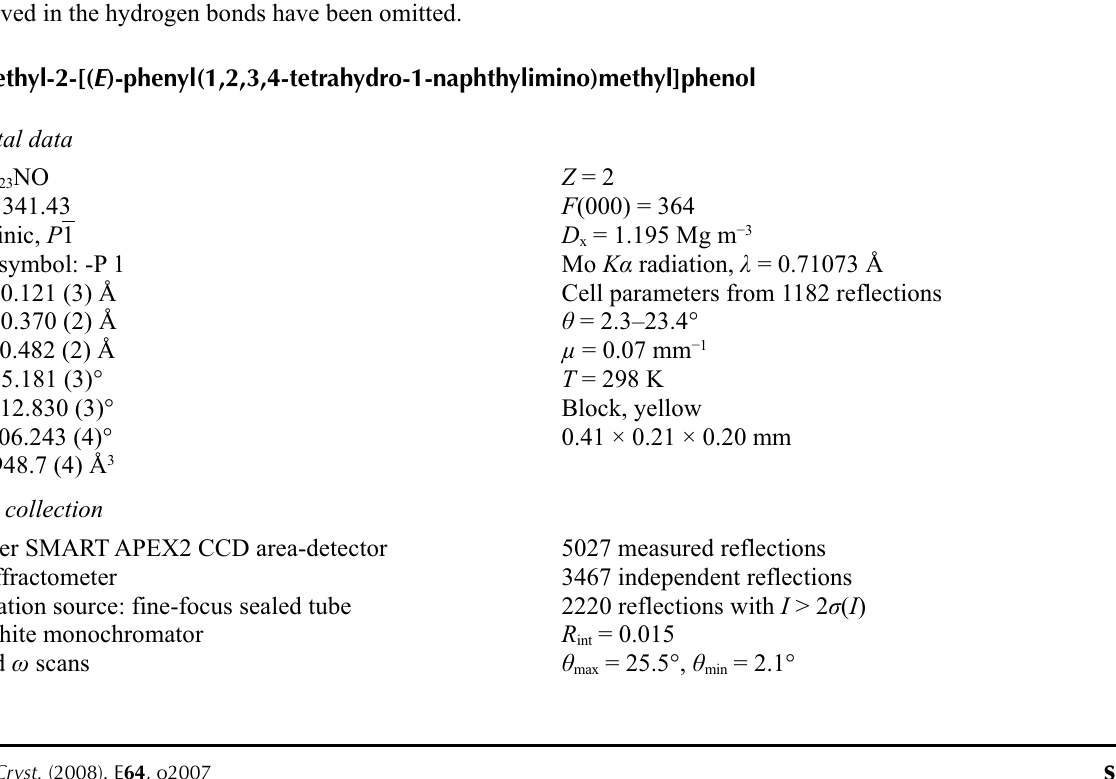
A packing diagram of (I), view down the b axis, showing the O1—H1···N1 hydrogen bonds (dashed lines). H atoms not involved in the hydrogen bonds have been